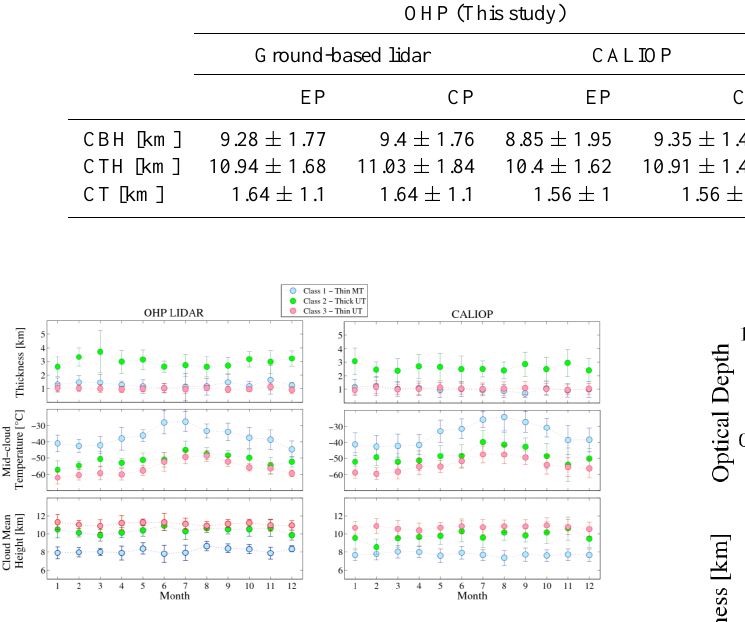
Figure 9. Monthly mean of macrophysical parameters of the different cirrus clouds classes. The blue, green and red lines represent respectively the results for the class 1 (thin cirrus in middle troposphere), the class 2 (thick cirrus in upper troposphere) and the class 3 (thin cirrus in upper troposphere). Panels on the left correspond to the OHP lidar data and those on the right to CALIOP data. From the top to bottom are respectively presented the cirrus clouds thickness, mid-cloud temperature and the mean height of the clouds.